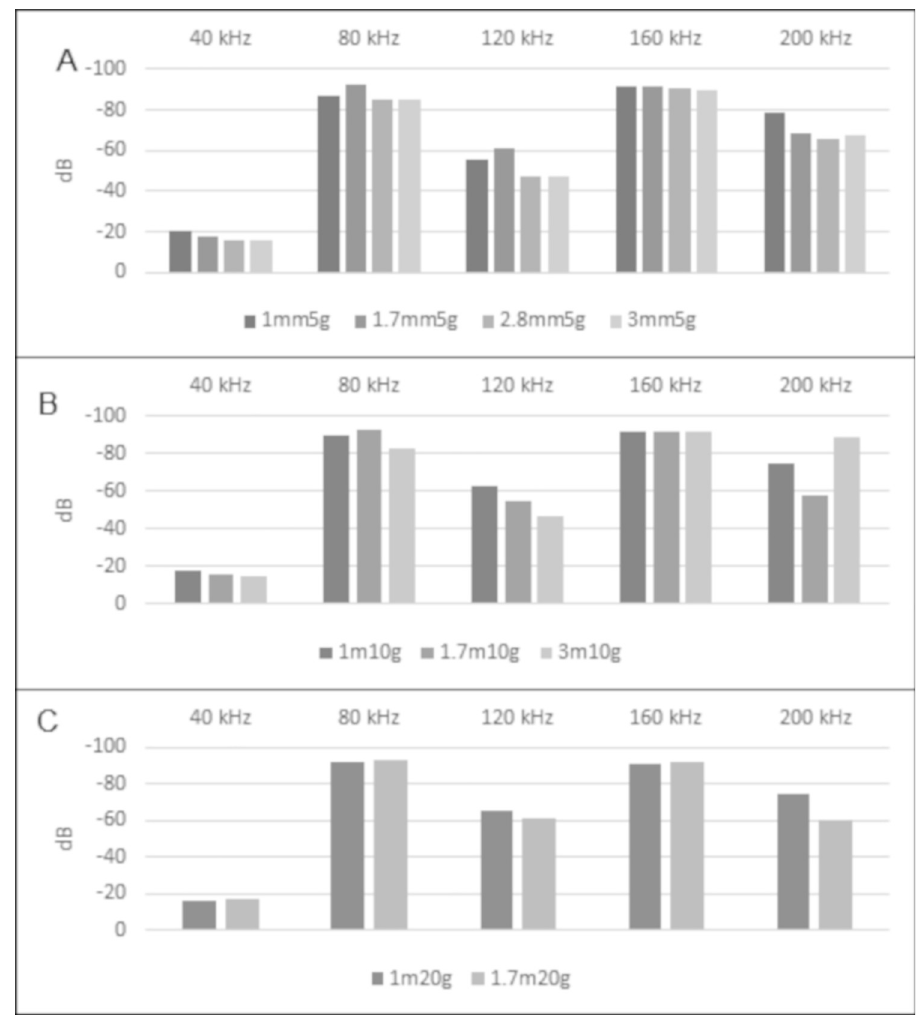
Fig 9. Groove width amplitude comparisons from the 40 kHz continuous tests. Amplitude in decibels (dB) of 40kHz continuous tone sound waves with harmonics generated at 40 cm distance and reflected by pinna models with groove separations of 1 mm, 1.7 mm, 2.8 mm, and 3 mm for pinna models with 5 grooves (A), 10 grooves (B), and 20 grooves (C). The strongest signal responses denoted in dB are closer to